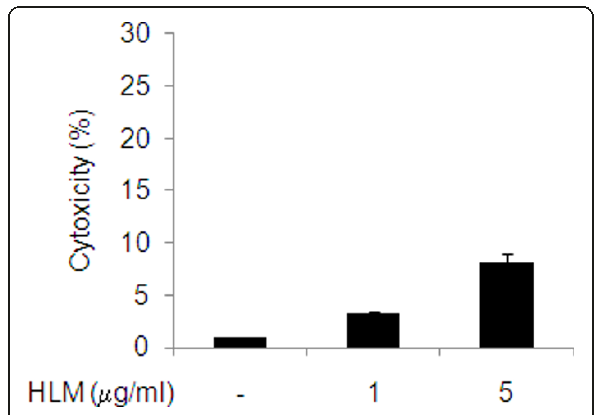
Figure 1 Chondrocyte viability after treatment with HLM ( Uncaria tomentosa ., Boswellia spp ., Lepidium meyenii and L- Leucine ) . Human OA chondrocytes were incubated with 1 and 5 μ g/ml of HLM for 24 h and viability was determined using release of lactate dehydrogenase (LDH) in culture supernatant. Values given are mean ± SD of 4